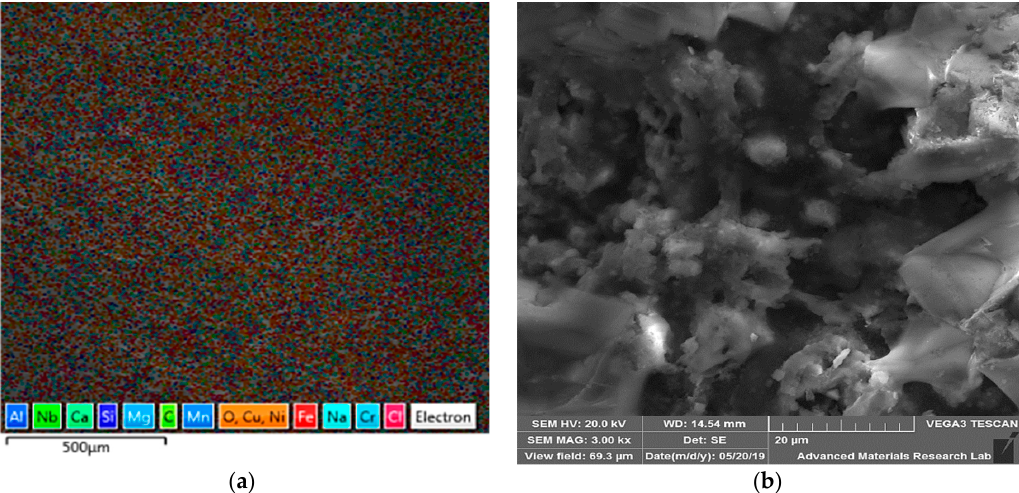
Figure 4. EDS and SEM for CT specimen; ( a ) specimen CT-EDS mapping for SS HAZ; ( b ) specimen CT-SEM on SS HAZ area.